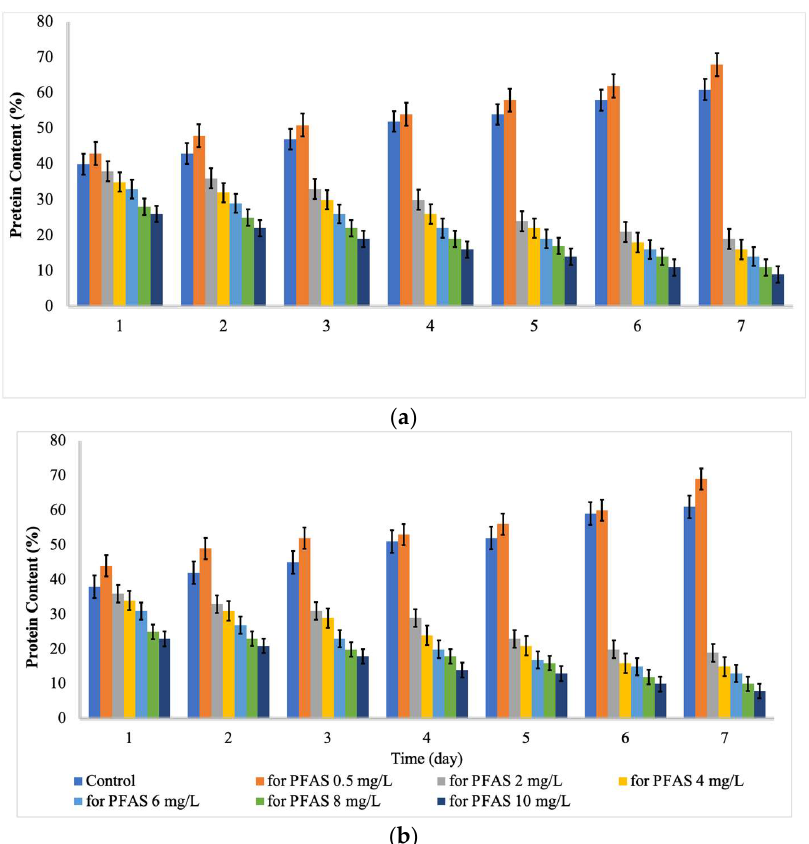
Figure 2. Total Chlorophyll ( mg L −1 ) at different concentrations of PFAS (mean ± error, n = 3); ( a ) for Chlorella vulgaris and ( b ) for Scenedesmus obliquus.